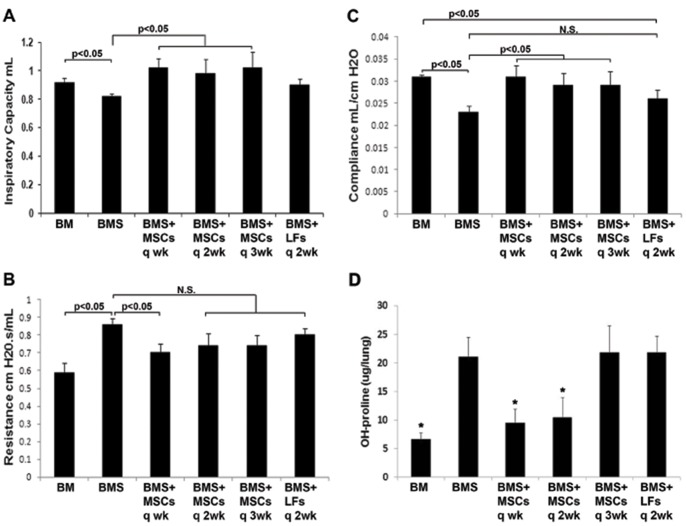
Late administration of MSC post-BMT reduces manifestations of OB.Starting at 4 weeks post-BMT, MSCs were administered IV every 1, 2 or 3 weeks until day 90. A. Inspiratory Capacity; B. Resistance; C. Compliance; D. OH-proline. Significant differences are indicated on graph. N = 6–14/group pooled from 2 experiments. LFs = mouse lung fibroblasts used as control cells.